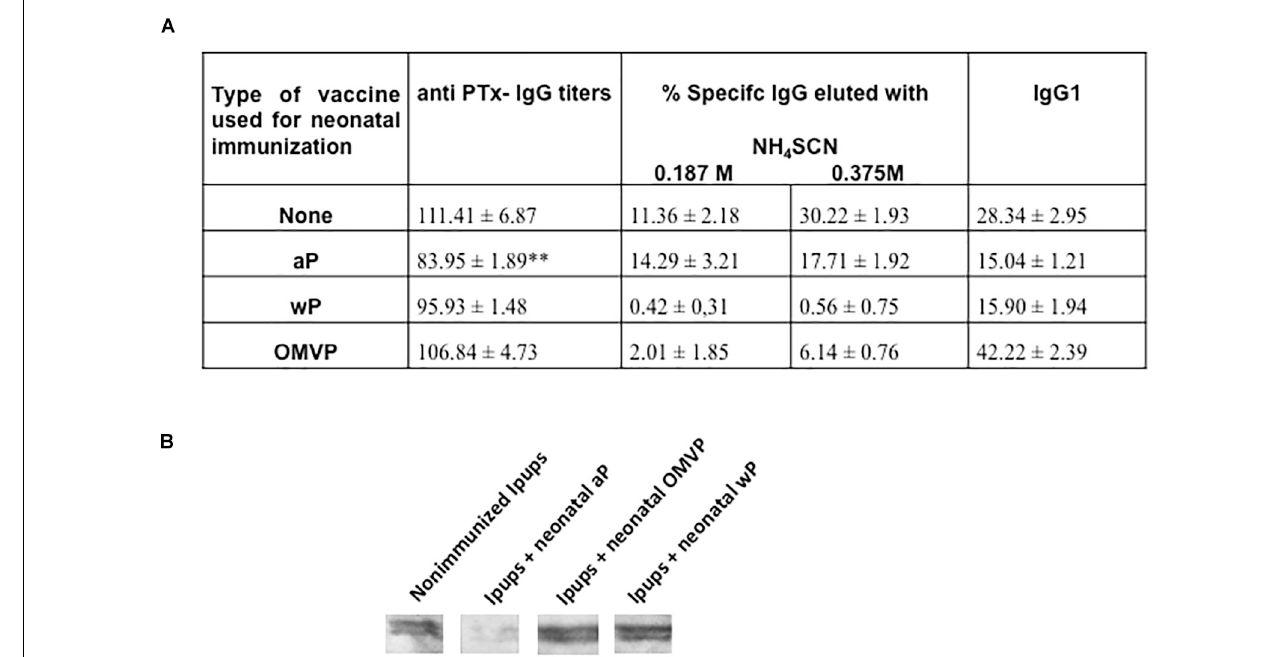
FIGURE 6 | Anti-Ptx antibodies in pups born to aP immunized mothers. (A) Anti-PTx IgG titers and the IgG1 isotype were measured at 21 days of life in the Ipups. The titers are expressed as the geometric mean of the data from each group. No values were detected in pups born to non-immunized mothers used as the control group (not indicated in the figure). The values detected in the aP-immunized Ipups were significantly lower ( p < 0.05) than those of the non-immunized mice. The cut-off levels for IgG and IgG1 assays were 12.5 ± 3.6 and 1.99 ± 0.98, respectively. The avidity of the IgG antibodies was also measured in the Ipups at 21 days of life, as indicated by the percentages of PTx-specific antibodies eluted after treatment with increasing concentrations of ammonium thiocyanate (NH 4 SCN). (B) Immunoblotting of purified PTx separated by 12.5% (w/v) SDS-PAGE and probed with the polyclonal antisera obtained from immunized mice. The sera are designated according to the vaccination schedule used to raise the immune response in